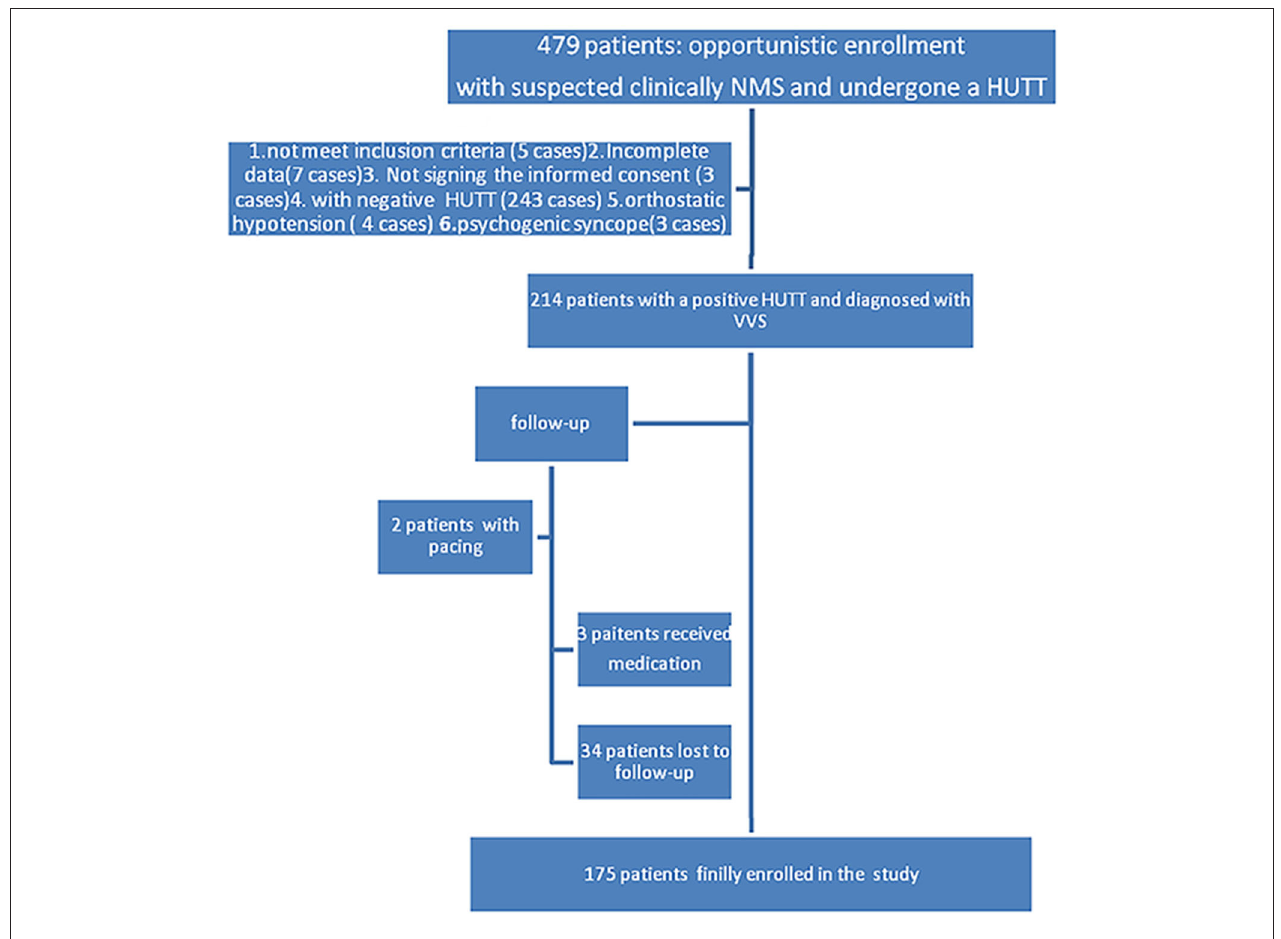
FIGURE 1 | A study flowchart with included and excluded